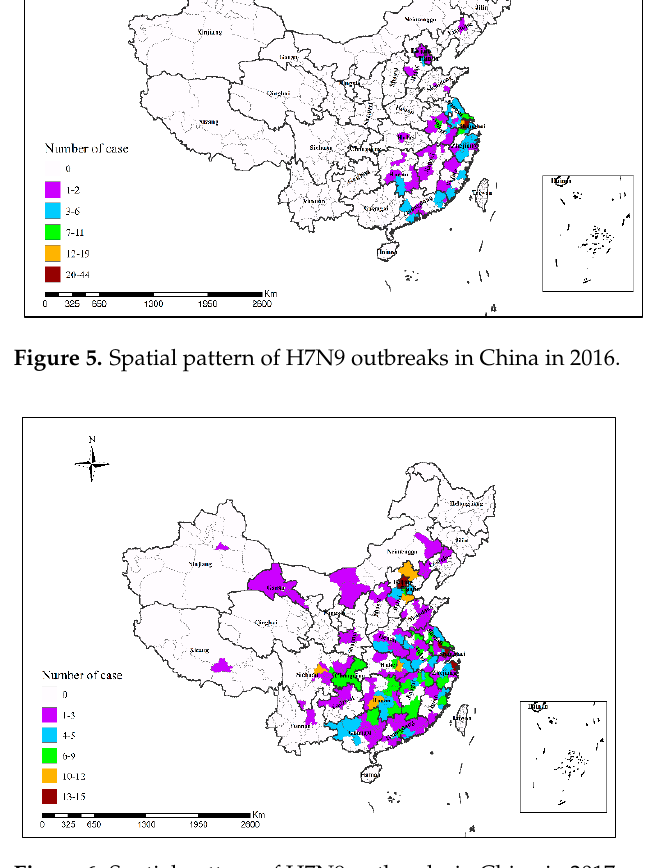
Table 1. Results of global spatial autocorrelation analysis and significance test of H7N9 outbreaks in China from 2013 to 2017.